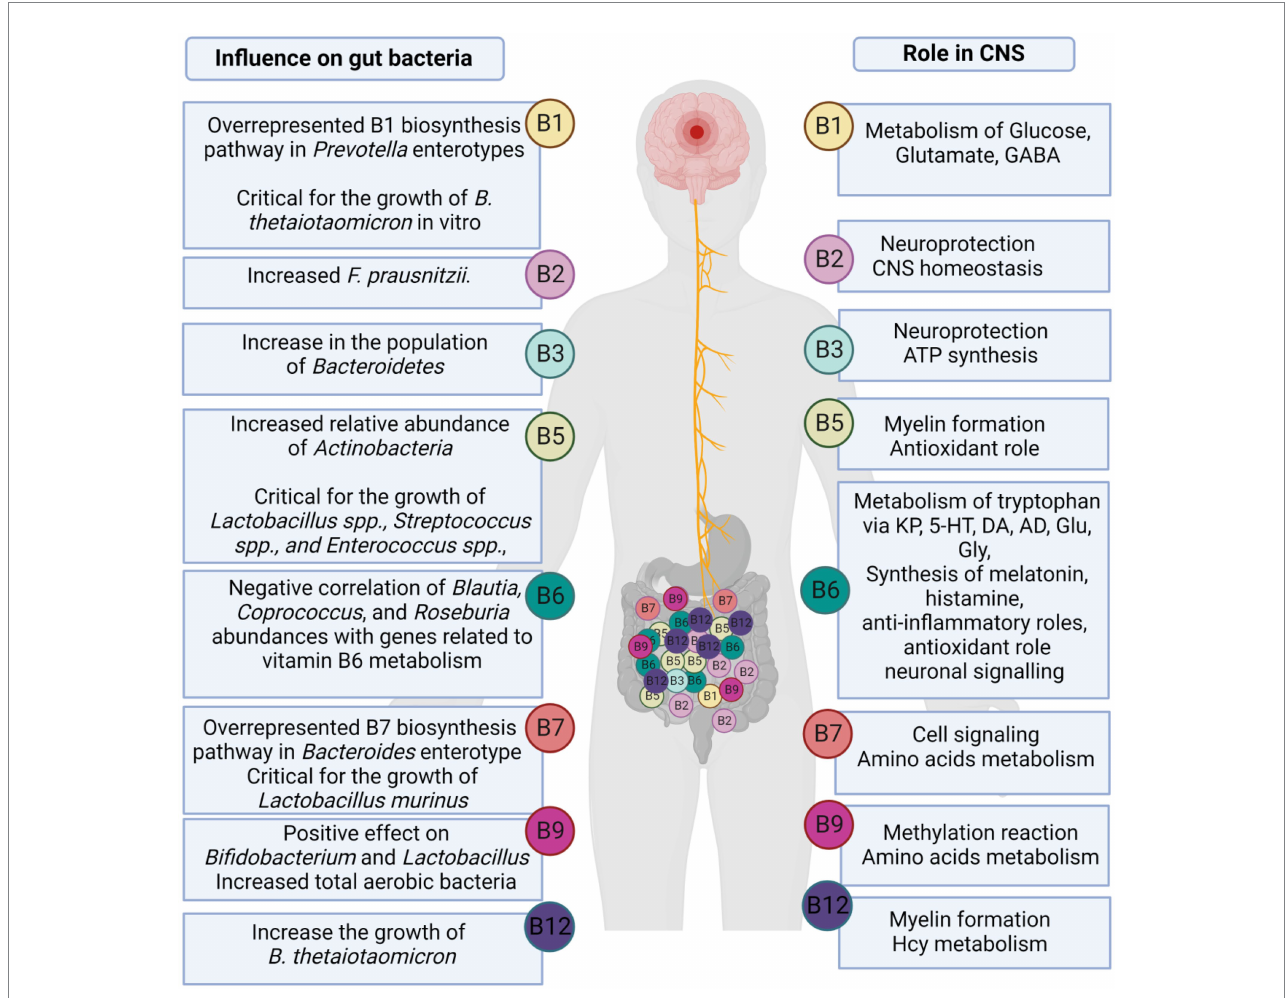
FIGURE 3 The role of microbially-produced B vitamins in CNS and gut